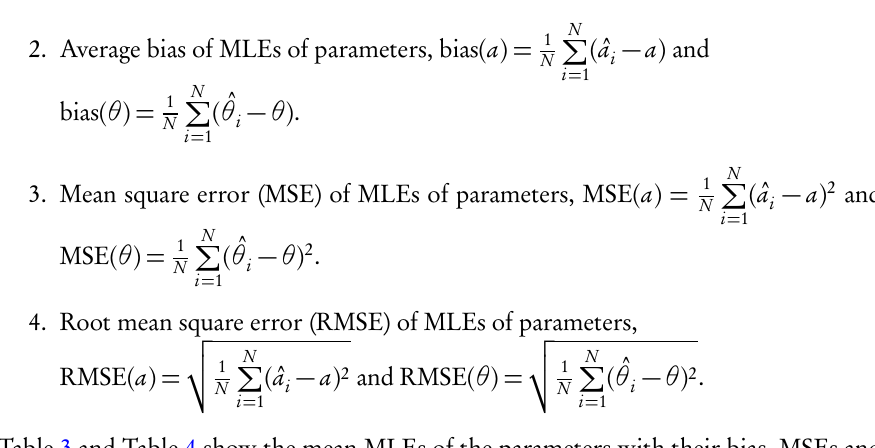
Table 3 and Table 4 show the mean MLEs of the parameters with their bias, MSEs and RMSEs. The simulation results for a = 1, θ = 5